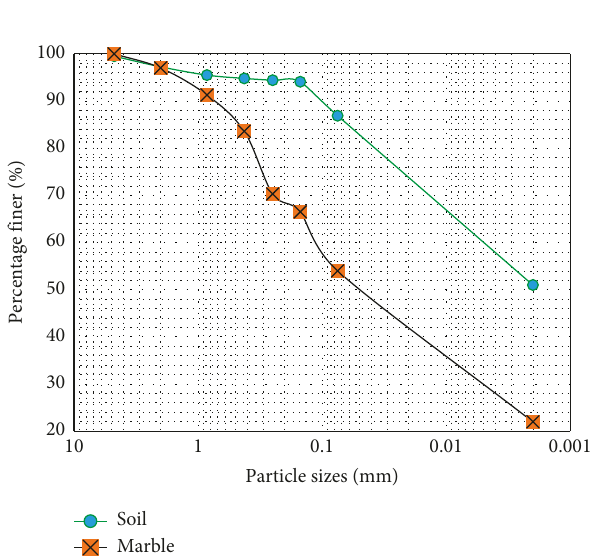
Figure 1: Gradation curves for the marble and